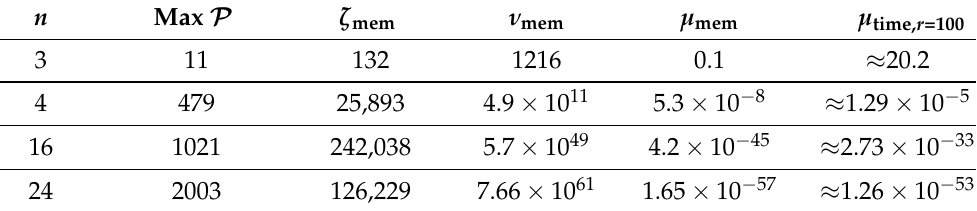
Table 3. Analysis of time and memory requirements of varying sizes of